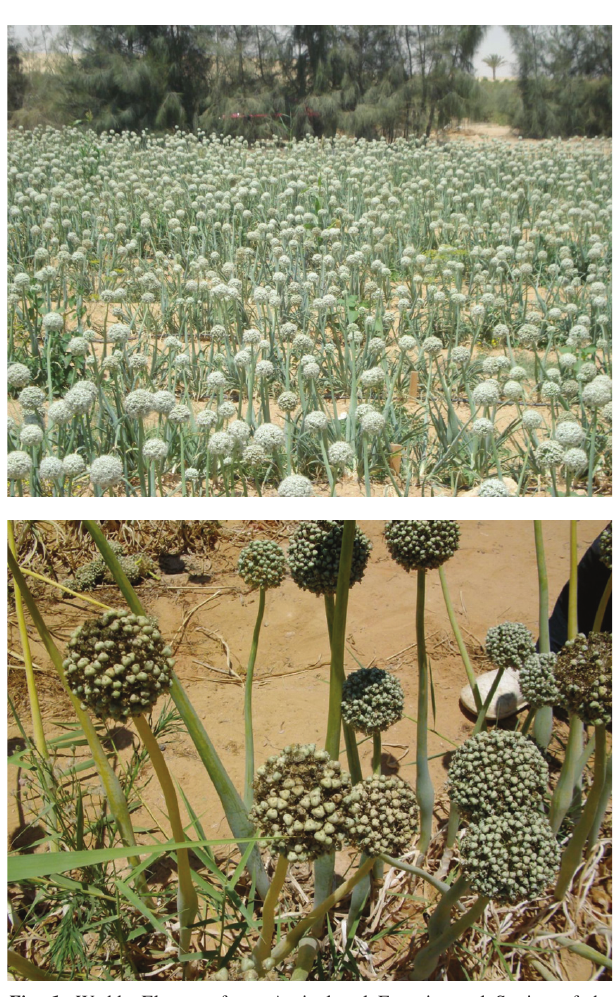
Fig. 1: Waddy Elnatron farm, Agricultural Experimental Station of the Faculty of Agriculture, Cairo University, where onion seed production under reclaimed sandy soil and high temperature. After 4 months, vegetative growth measured such as flower stalks length, inflorescence diameter and number of seeds stalk/plant (photo by K. Abd